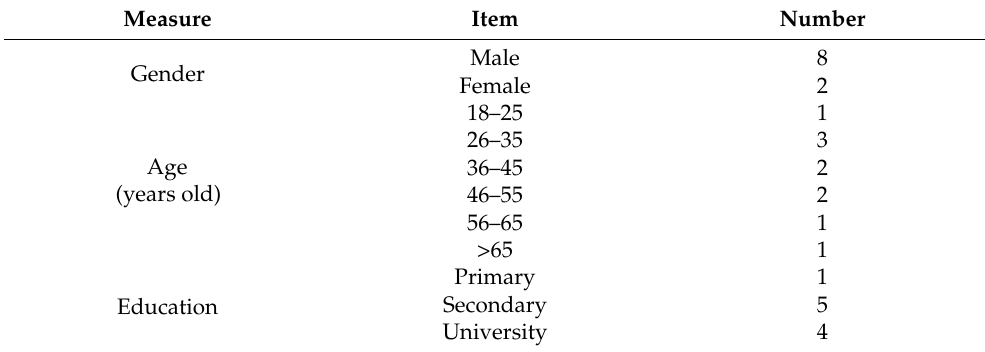
Table 2. Evaluators’ demographics.